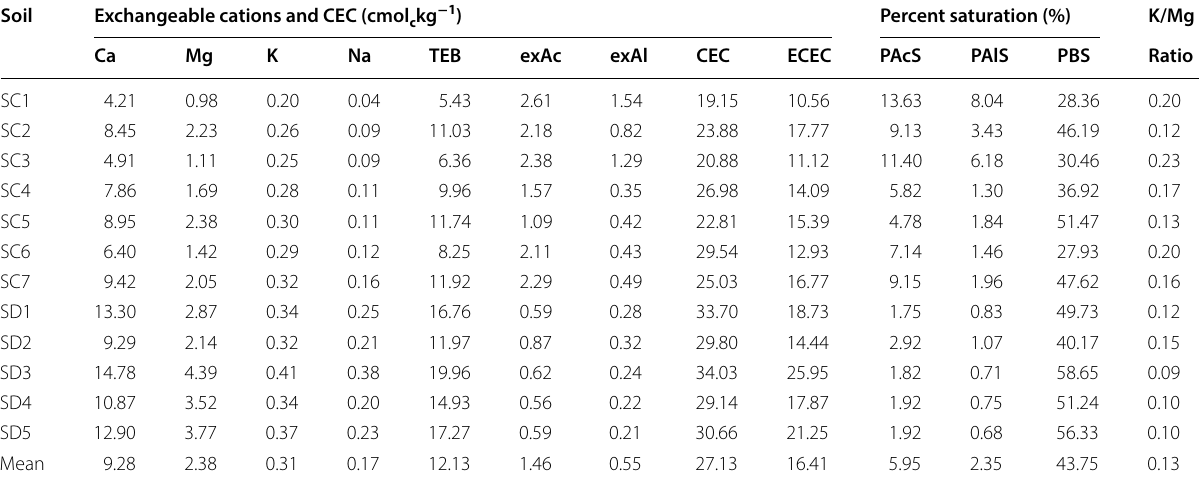
Table 4 Exchangeable cations and exchange